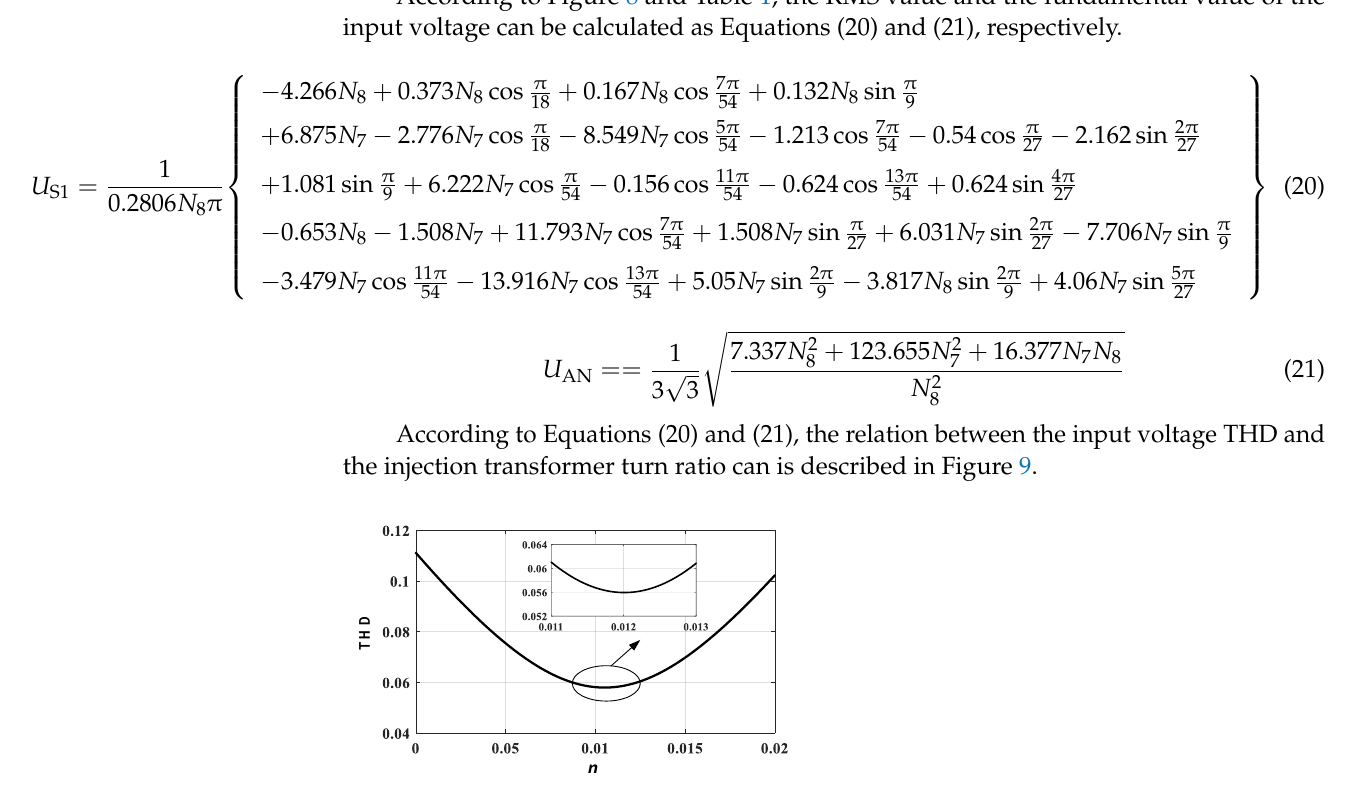
Figure 8. Voltage u AN in one supply cycle.